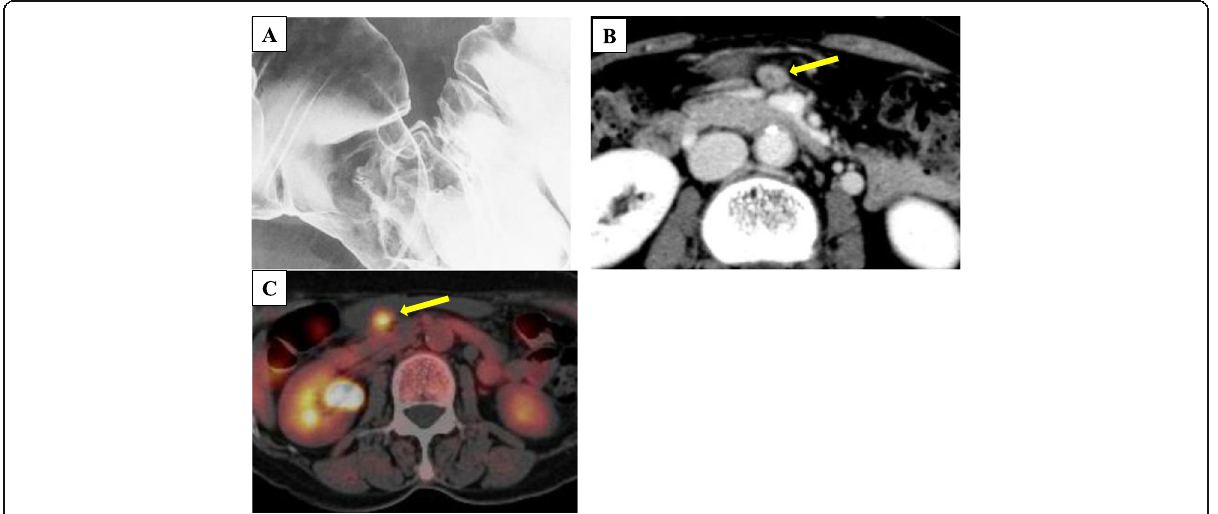
Fig.2 a Barium enema examination revealed a trapezoid-formed change at the hepatic flexure of the transverse colon. b Abdominal enhanced CT showed an enlarged intermediate lymph node (arrow). c PET/CT revealed an abnormal accumulation of SUVmax 3.8 on the intermediate lymph node (arrow).